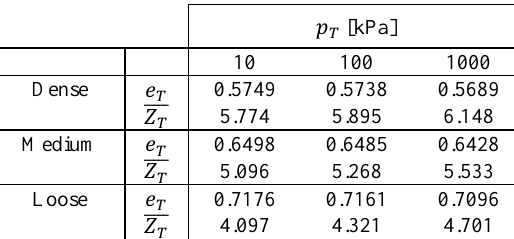
Table 4 . 𝑒 𝑇 and 𝑍 𝑇 ̅̅̅̅ values of the random